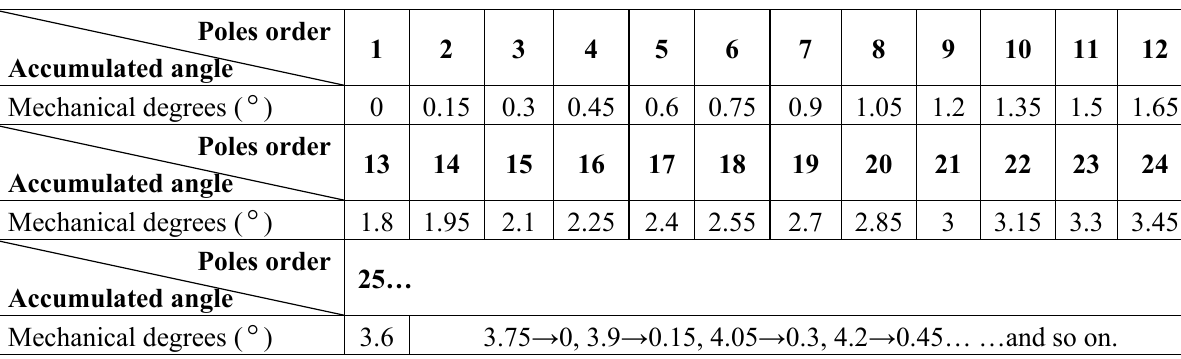
Table 3. Mechanical degrees of 100-pole and 96-slot.